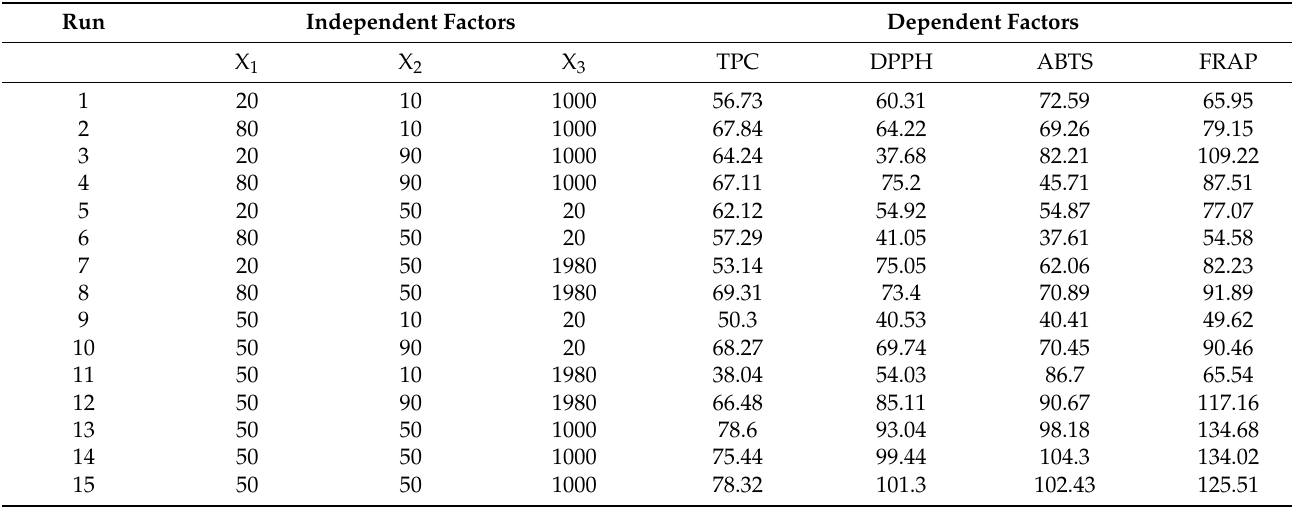
Table 1. Experimental Box–Behnken design (BBD), with natural and coded values for the factors, and response variable values.